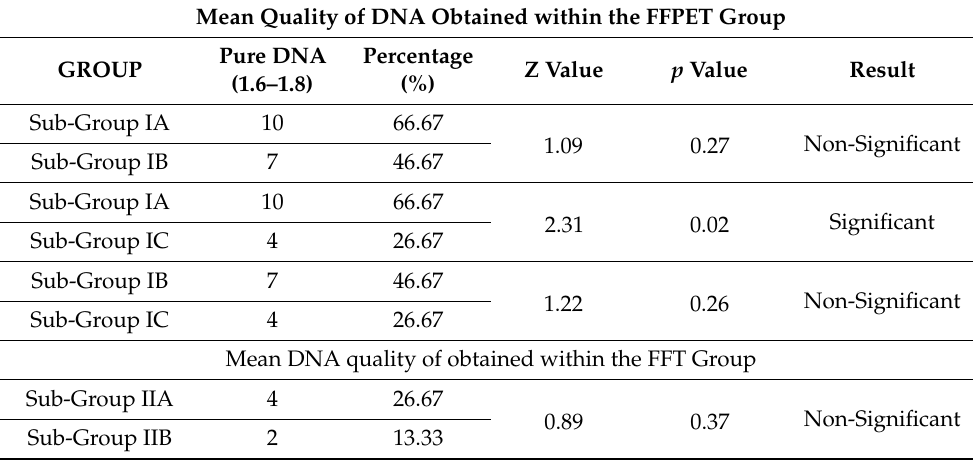
Table 7. Comparison of the mean DNA quality obtained within the